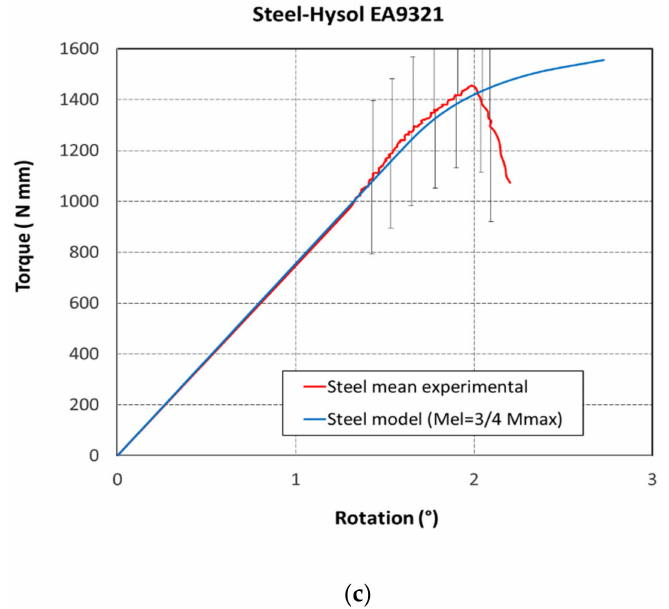
Figure 5. Mean experimental and model curves for the THG samples under torsion: cases of adherends in Si3N4 ( a ), SiC ( b ), and steel ( c ). Vertical bars stand for ± one standard deviations. Cohesive failure of the surface-structured Si3N4 ( a ) showed an evident plastic behaviour in the experimental torsion curve, while interfacial failure of SiC ( b ) and steel ( c ) corresponded to a limited plastic region.